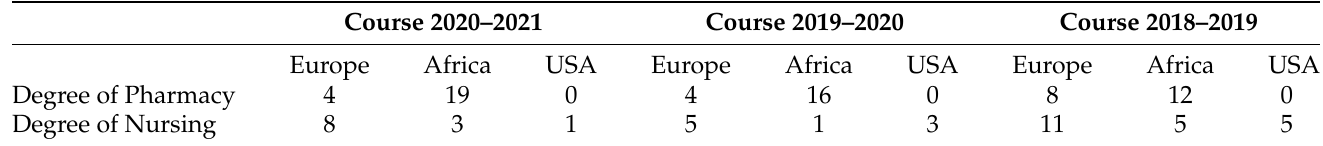
Table 3. Origin of the students according to the degree.